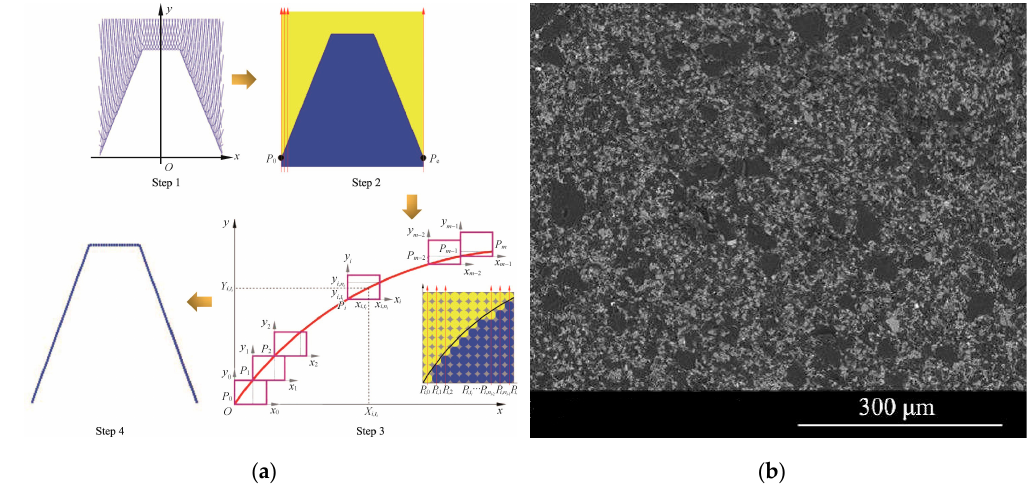
Figure 5. ( a ) The worm wheel grinding principle; ( b ) 20CrMnTiH surface texture.